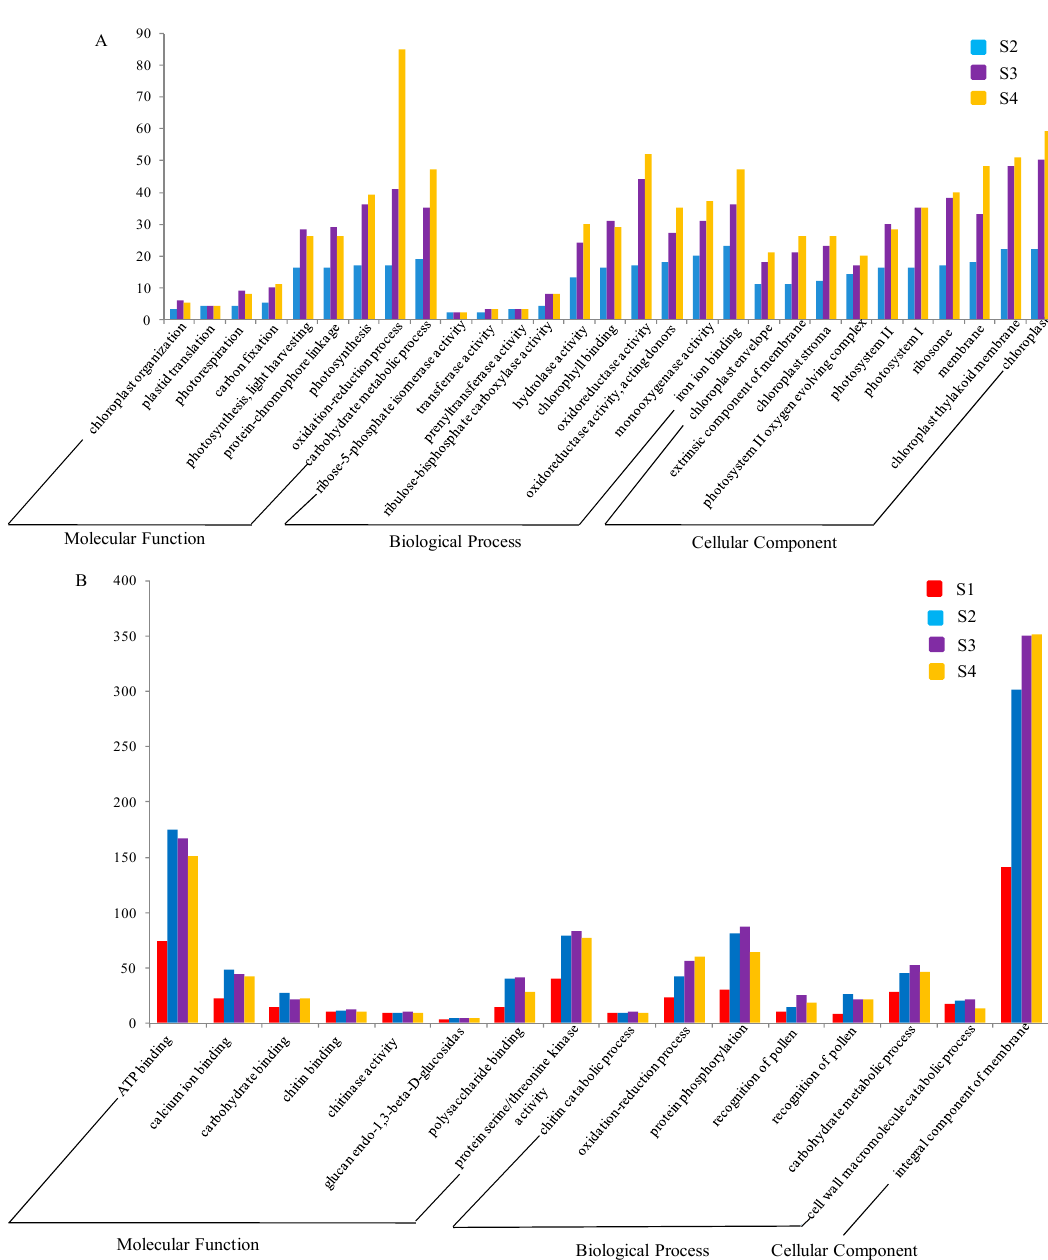
Figure 4. Gene Ontology (GO) enrichment analyses of down- and up-regulated DEGs between the WT and m68 at different stages. Twenty-nine and sixteen GO terms are shown in down- and up-regulated DEGs, respectively. ( A ) GO enrichment analyses of down-regulated DEGs; ( B ) GO enrichment analyses of up-regulated DEGs; The Y -axis indicates the number of genes belonging to the GO terms below. The X -axis indicates GO terms. The DEGs at S1, S2, S3, and S4 are shown in red, blue, purple and yellow , respectively.